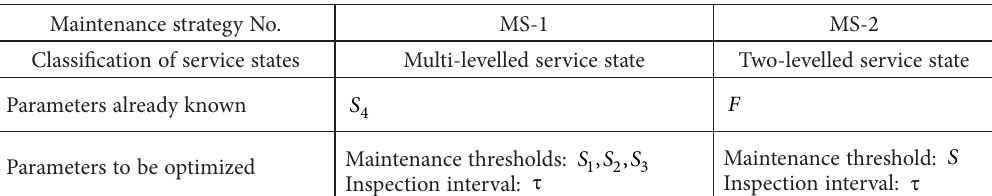
Table 3. Parameters to be optimized in different maintenance strategies Maintenance strategy